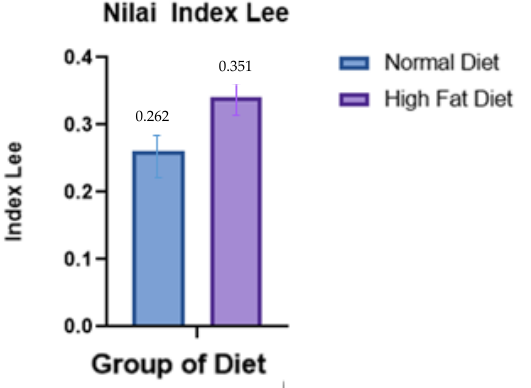
Figure 1. Bar chart for comparison of body weight of mice. Blue color: a group of normal mice; purple color: a group of obese mice. P = significant ( p = 0.000, p < 0.01).